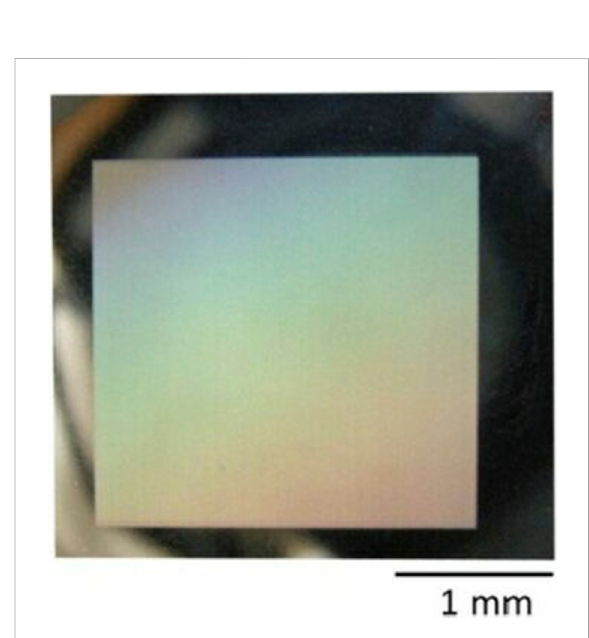
FIGURE 11 Image of typical iridescent effect on the irradiated surface by femtosecond laser (Guan et al.,